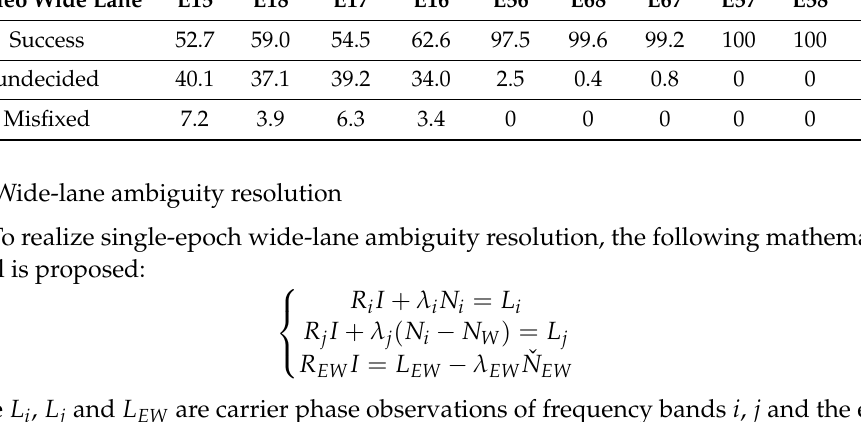
Table 5. Fixing rate of the single-epoch ambiguity resolution of the GPS wide-lane combination (%). GPS Wide Lane G15 G12 G25 success 50.1 53.9 undecided misfixed 9.3 7.4 0 Table 6. Fixing rate of the single-epoch ambiguity resolution of the BeiDou wide-lane combina- tion (%). BeiDou Wide Lane C15 C25 C27 C12 success 54.3 48.8 misfixed Table 7. Fixing rate of the single-epoch ambiguity resolution of the Galileo wide-lane combination (%). Galileo Wide Lane E15 E18 E17 E16 E57 E78 Success 52.7 59.0 undecided